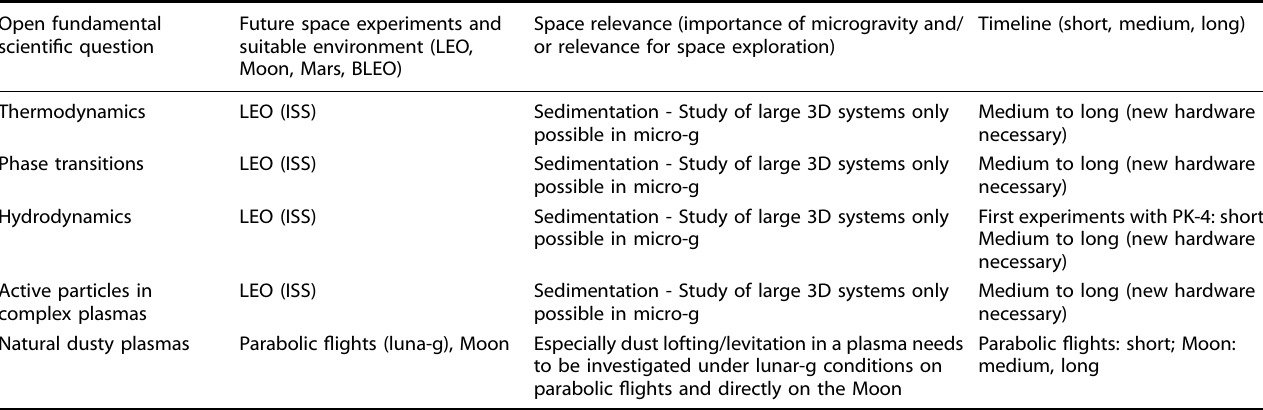
Table 1. Open fundamental scienti fi c question for complex plasma research under